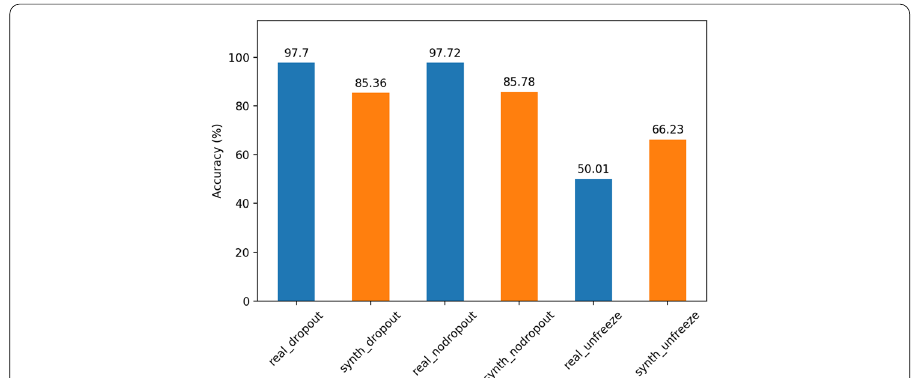
Fig. 3 Accuracy of the real and synthetically trained models using dropout, no dropout, and allowing for the VGG weights to be trainable (unfreezing)